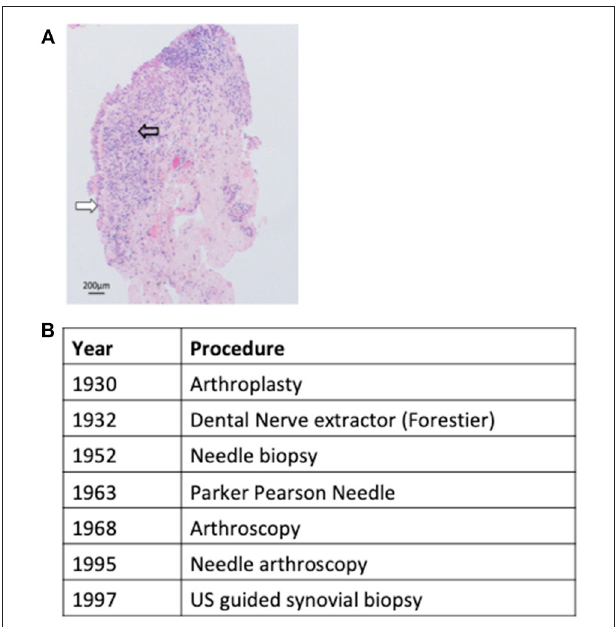
FIGURE 1 | Synovial sampling techniques. (A) Representative image of RA synovial tissue demonstrating hypertrophy of lining layer (white arrow) and sublining infiltration by lymphocytes (open arrow). (B) The development of minimally invasive synovial sampling